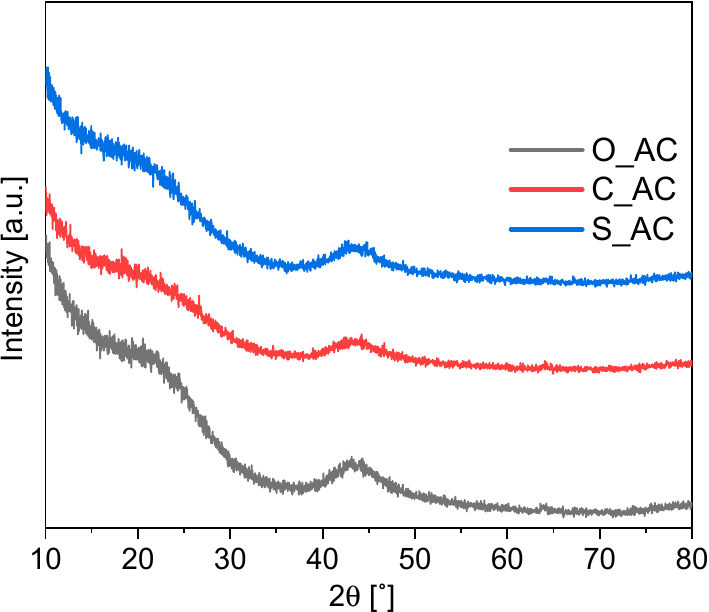
Figure 3. Diffractograms of activated carbons from biomass.